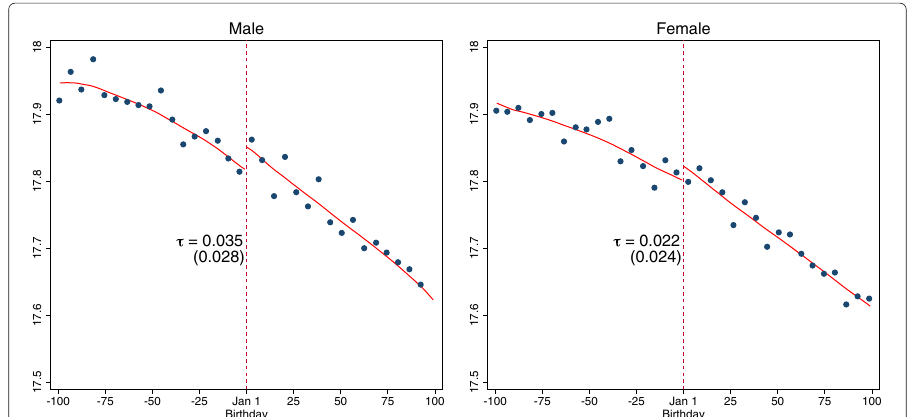
Fig. 6 Age of first-time college candidates. This figure shows the relationship between the birthday and the age at which candidates apply for college for the first time. The center of the graphs is zero, which represents January 1. The first graph shows the relationship for boys and the second for girls. Data come from applications for undergraduate programs at UFPE from 2002 to 2005. The sample is restricted to those who graduated from high school in the same year and were under 18.5 years old. Functions are estimated using a triangular kernel with the bandwidth selection procedure proposed by Calonico et al. (2014). τ is the RD estimate, with robust standard errors in